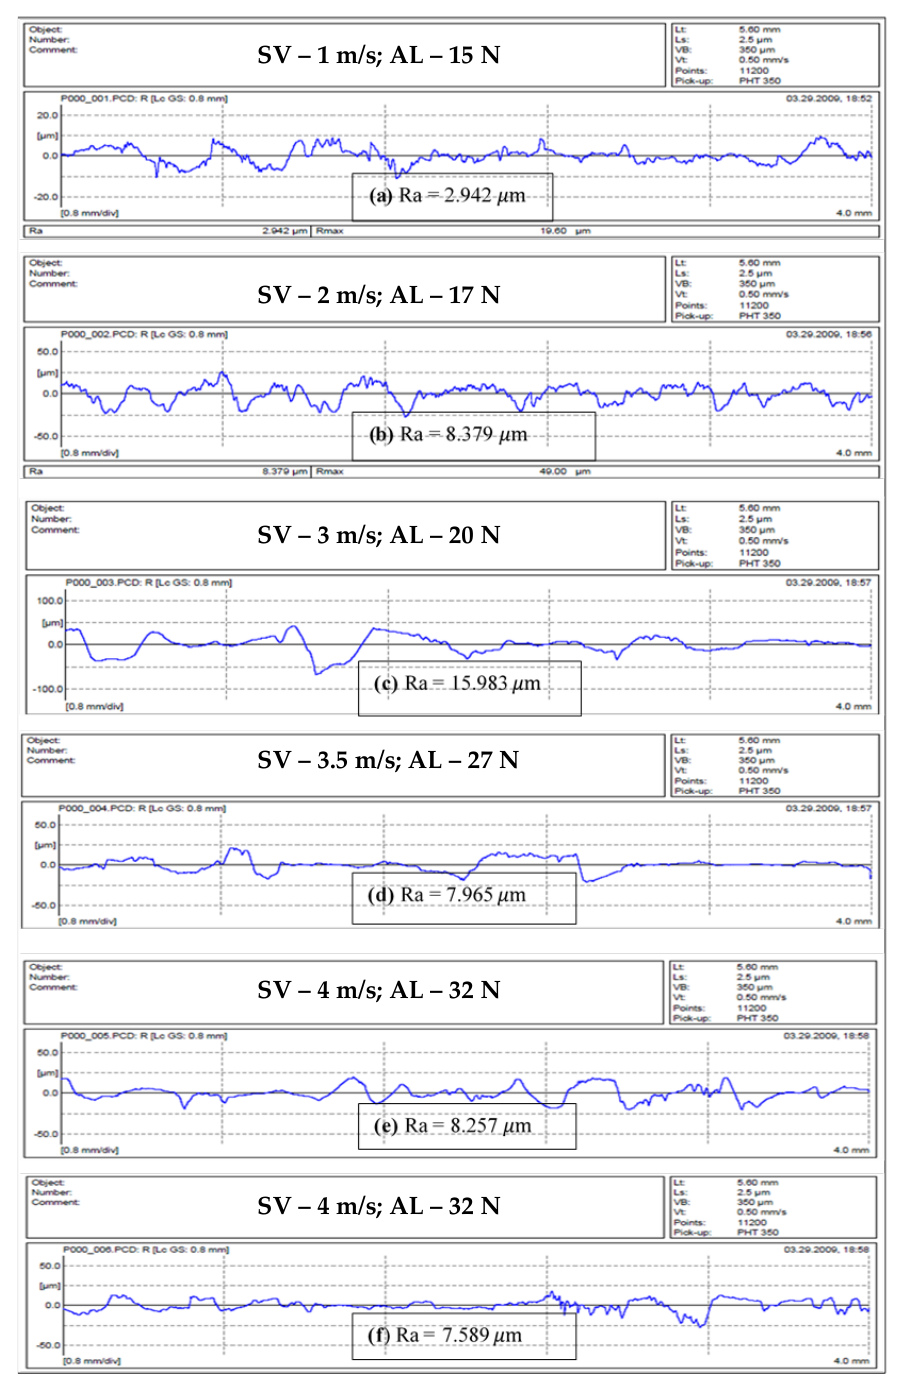
Figure 12. Roughness profile of S-BFRE composite. Note: SV—Sliding Velocity; AL—Applied Load.